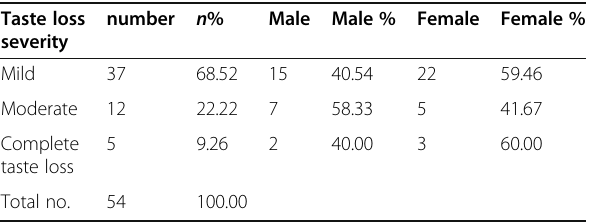
Table 2 Taste loss severity gender